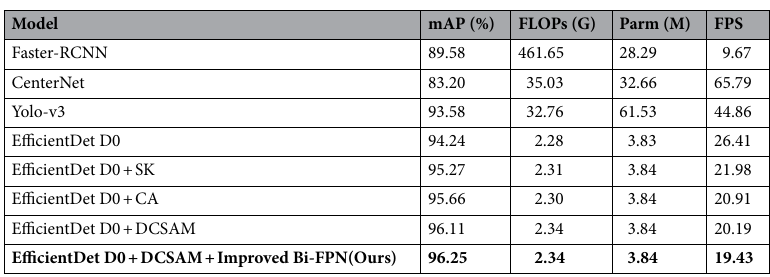
Table 2. Comparison of mAP, FLOPs, Parm and FPS of different detection algorithm models. Experimental results of final model are in bold.